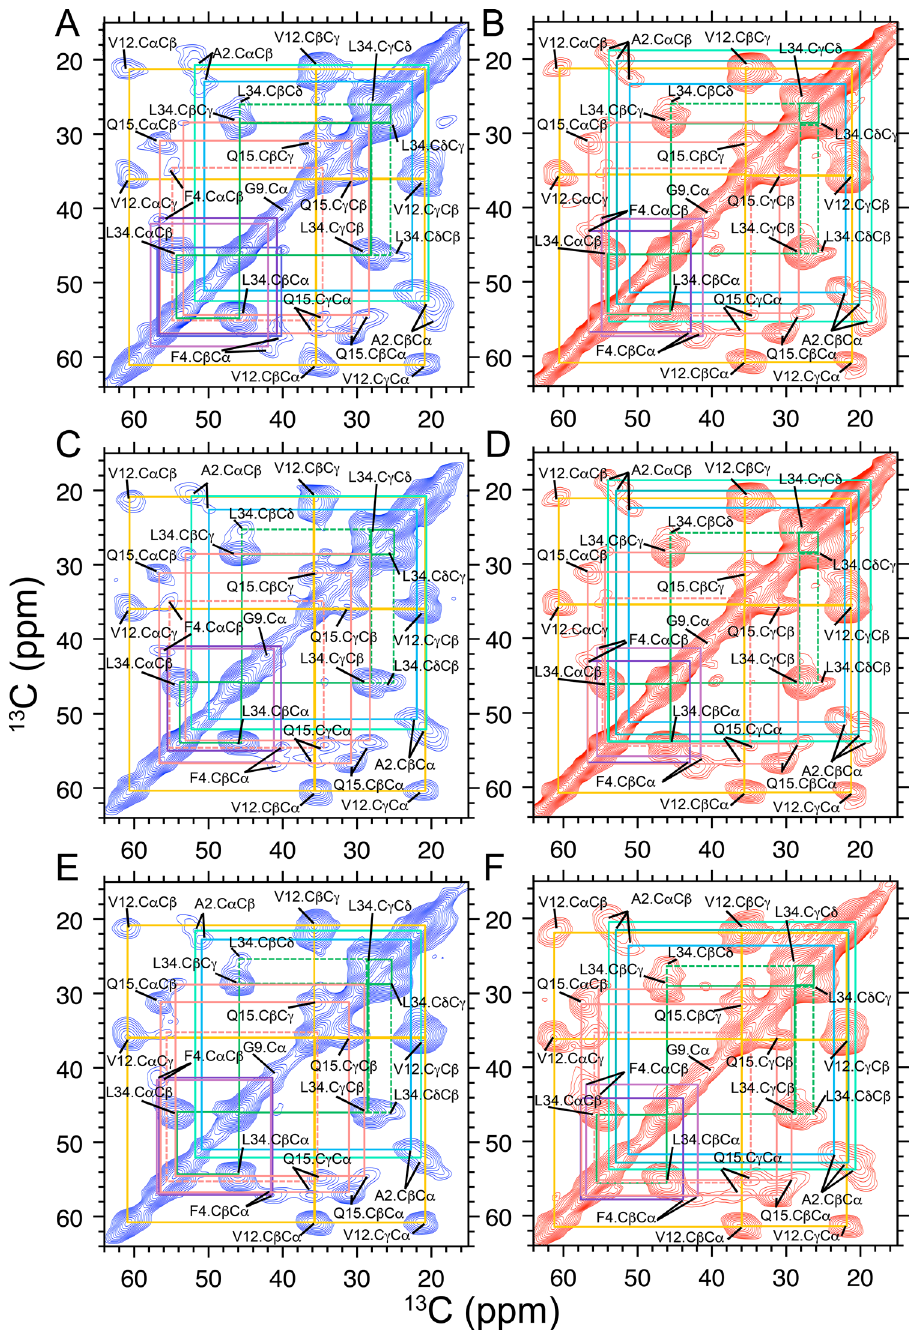
Figure 3. CC2D SSNMR spectra (side chain carbon region) for Aβ40 fibrils seeded by brain isolates. ( A , B ) CC2D SSNMR spectra for Aβ40 for Patient 1. ( C , D ) CC2D SSNMR spectra for Aβ40 for Patient 2. ( E , F ) CC2D SSNMR spectra for Aβ40 for Patient 3. For all three patients, spectra of vascular-seeded fibrils are shown first and in blue, and those of parenchyma-seeded fibrils are shown second and in red. Assignments for neighboring 13 C correlations are solid lines; assignments for long distance 13 C correlations are dashed